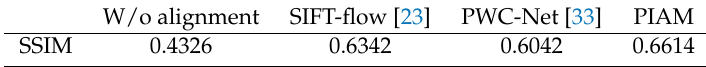
Table 4. Quantitative evaluation for matching accuracy in [19].